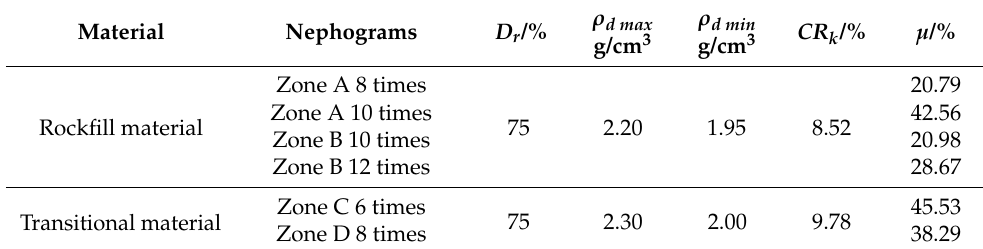
Table 4. CR k and qualified ratio ( µ ) of the filling